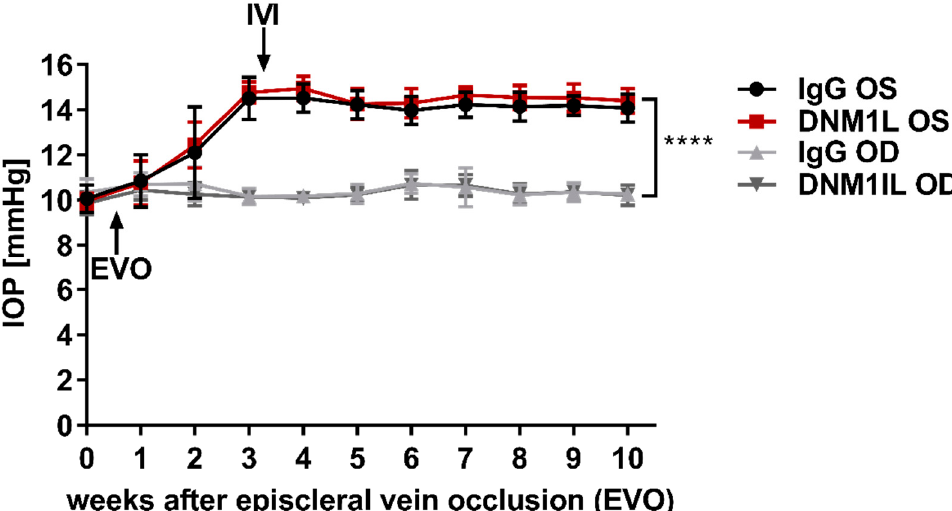
Figure 1. Longitudinal IOP monitoring. Rebound tonometry was used to examine IOP once a week. IOP was stably elevated three weeks after episcleral vein occlusion (EVO) at the OS. Stable IOP elevation was followed by intravitreal injection (IVI) of either IgG control antibody (IgG OS, Black) or anti-DNM1L antibody (DNM1L OS, Red). The contralateral OD, IgG OD (light gray), and DNM1L OD (dark gray), received no interventions and served as internal controls. IOP remained stably elevated until the end of the study. The increase in w10 was statistically significant. **** p < 0.0001, student’s t -test. Numbers of animals used: n = 7 (IgG), n = 8 (DNM1L).